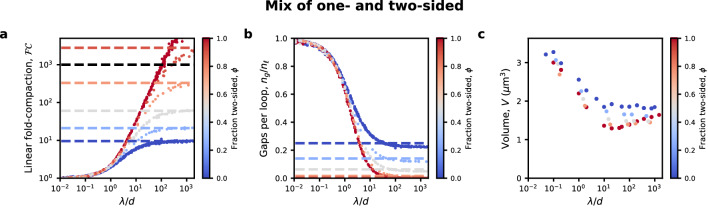
Compaction in model with a mix of one- and two-sided LEFs.(a) Strong linear compaction can only be achieved with a high fraction of two-sided LEFs. Colored dashed lines show prediction from mean-field theory (Banigan and Mirny, 2019) for compaction in the limit of large λ/d, while black dashed line indicates FC = 1000, expected for human chromosomes. (b) Gaps remain in systems with a one-sided LEFs, as quantified by the number of gaps per loop, ng/nℓ. Dashed lines indicate the expected number of gaps per loop. (c) Volumetric compaction for different fractions of two-sided extrusion.